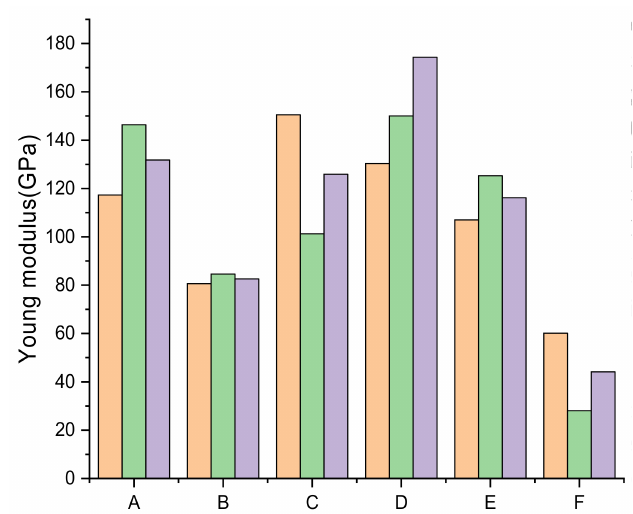
Figure 15. Distribution range of Young’s modulus value in in bright-white area.